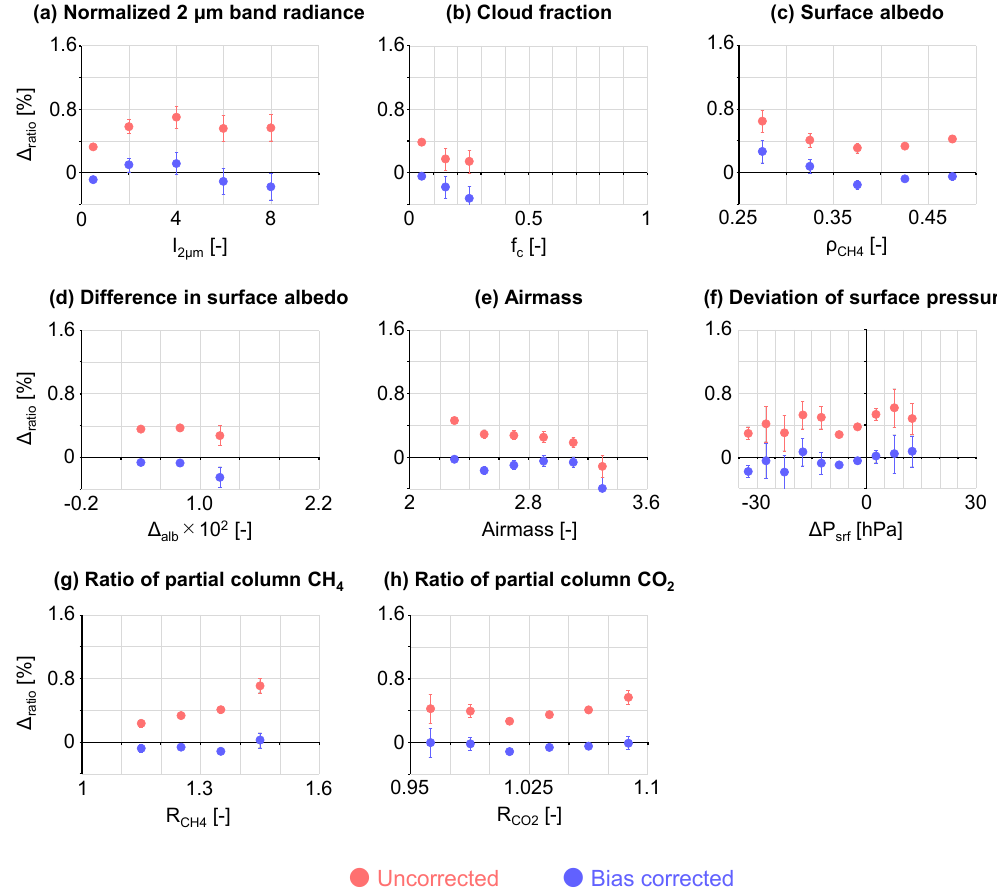
Figure A5. Relationship between the relative difference in the ratio component between GOSAT and TCCON ( Δ ratio ) and the related variables for the GOSAT data acquired with gain M: ( a ) normalized 2 μ m band radiance (I 2 μ m ); ( b ) cloud fraction (f c ); ( c ) retrieved surface albedo of CH 4 band ( ρ CH4 ); ( d ) difference in the retrieved surface albedo (CH 4 band minus CO 2 band, Δ alb ); ( e ) airmass (A m ); ( f ) deviation of the retrieved clear-sky surface pressure from its prior ( Δ P srf ); ( g , h ) ratio between the partial column-averaged dry-air mole fractions for the lower atmosphere and that for the upper atmosphere (R CH4 and R CO2 ). Mean Δ ratio for each bin is plotted for the bias-uncorrected and bias-corrected data.